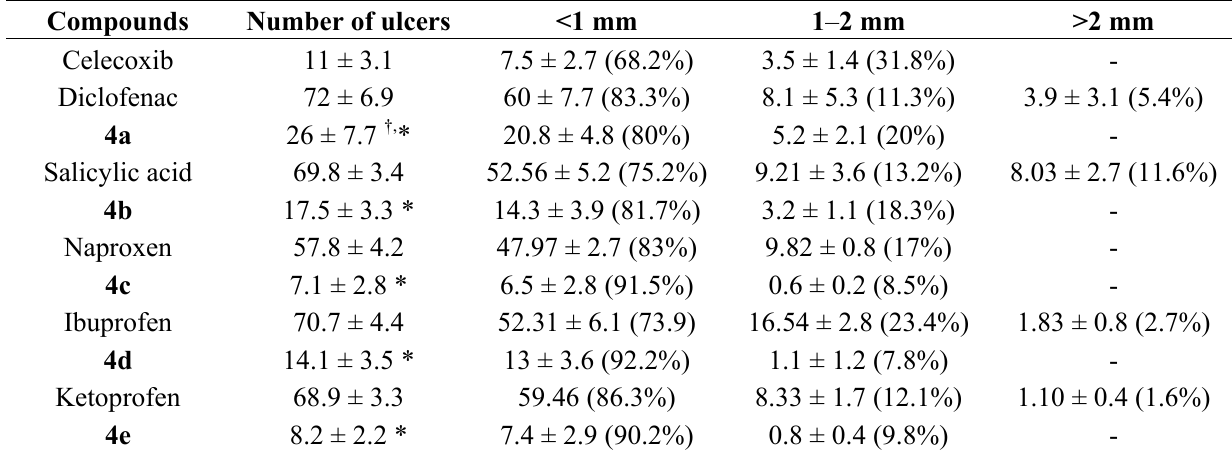
Table 3. Ulcerogenic effect of diclofenac and compounds 4a – e in rats ( n = 6, mean ± S.D.).